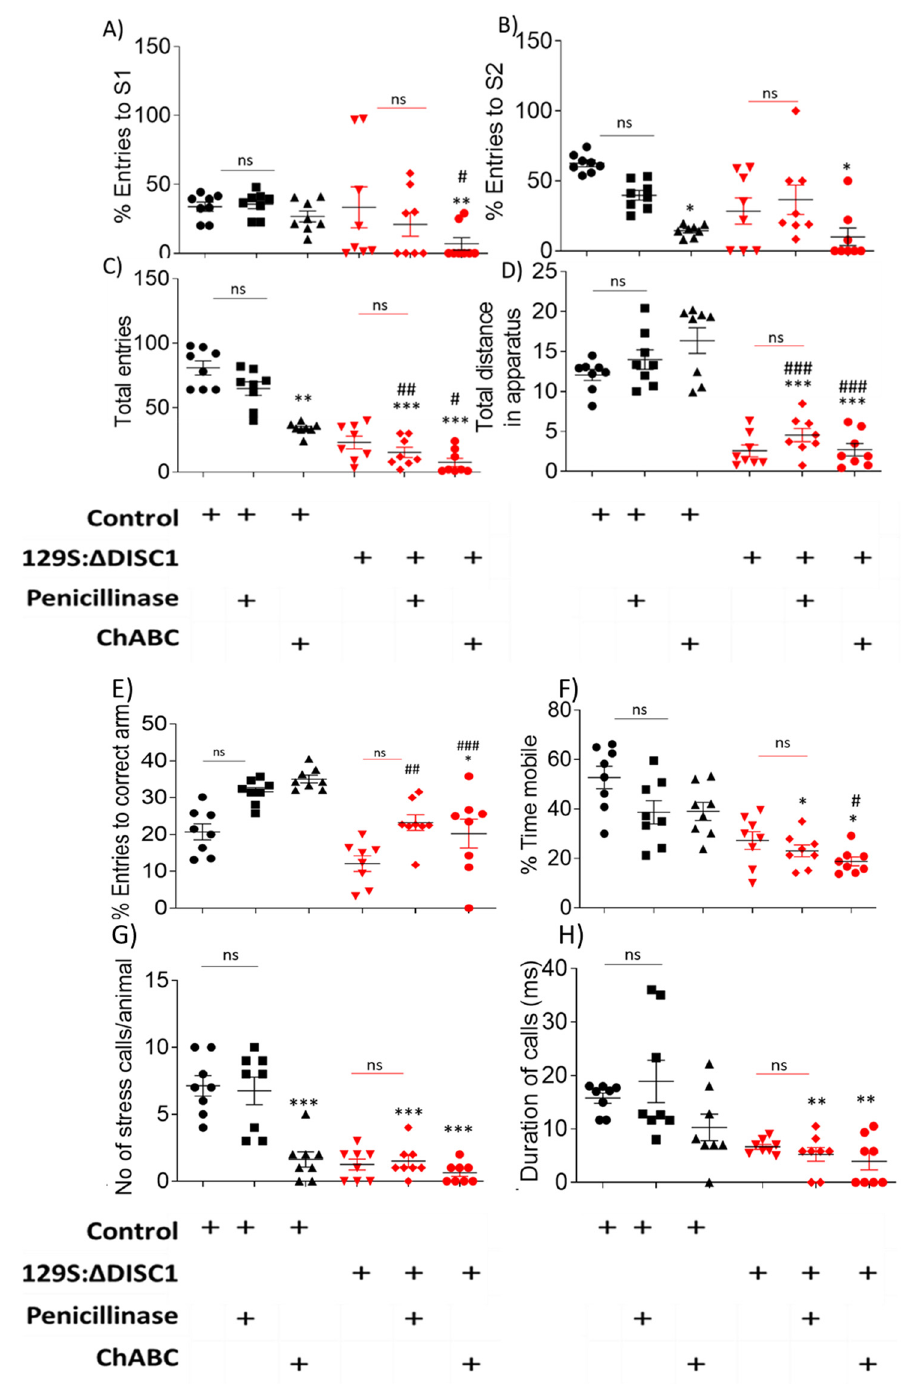
Figure 4. Behavioral analysis of chondroitinase and penicillinase treated animals. ( A ) sociability test as measured by the percent entries to the stranger 1 (S1) chamber; ( B ) novelty test as measured by the percent entries to the stranger 2 (S2) chamber; ( C , D ) The overall activity of the animals was assessed in terms of total entries from one chamber to another ( C ) and the total distance travelled throughout apparatus in meters ( D ). ( E ) In the Y-maze task, working memory was assessed by the percent entries into the correct arm of the maze; ( F – H ) stress responses were measured by the percent mobility time in a tail suspension test ( F ) and the stress calls produced during tail suspension test ( G , H ). Black and red symbols indicate Control and DISC1 mutation animals, respectively. The data are represented as plots showing mean ± s.e.m. where * or # p ≤ 0.05, ** or ## p ≤ 0.01, *** or ### p ≤ 0.001, where the symbols express the comparison of chDISC1 mutation animals with “*” represents comparison vs. Penicillinase control and “#” represents comparison vs. Chondroitinase control.